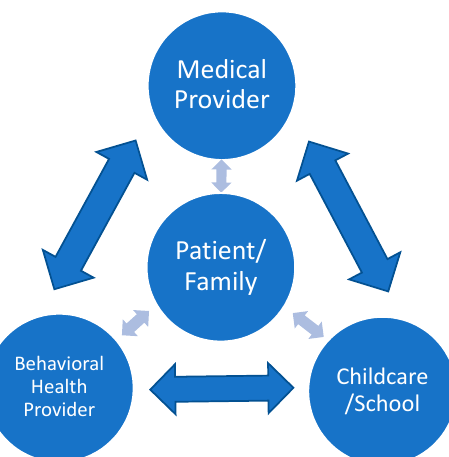
Figure 1. Multidisciplinary approach to the assessment and intervention of sleep problems with emphasis on communication between patients/families and providers as well as across providers.